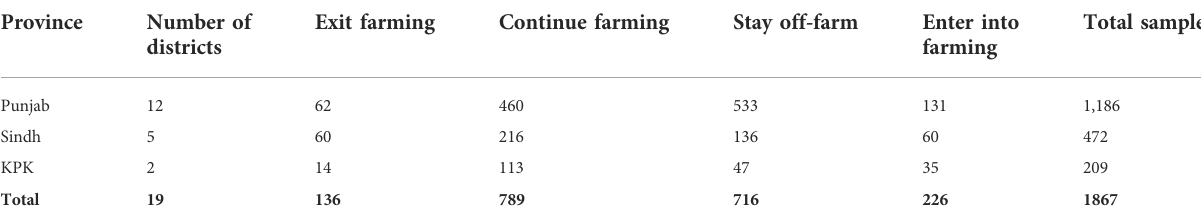
TABLE 1 Study provinces and sample size.